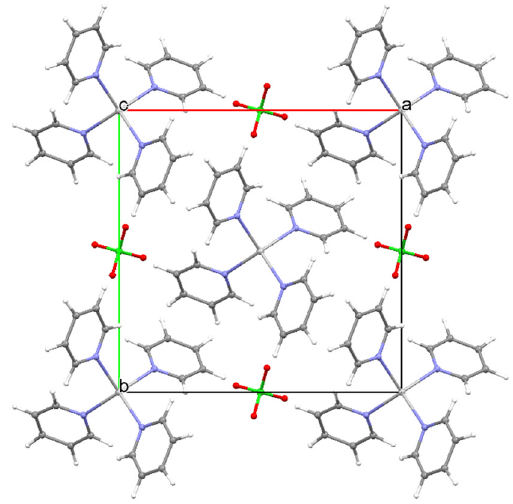
Figure 6. Structure and packing in compound 5b [8].